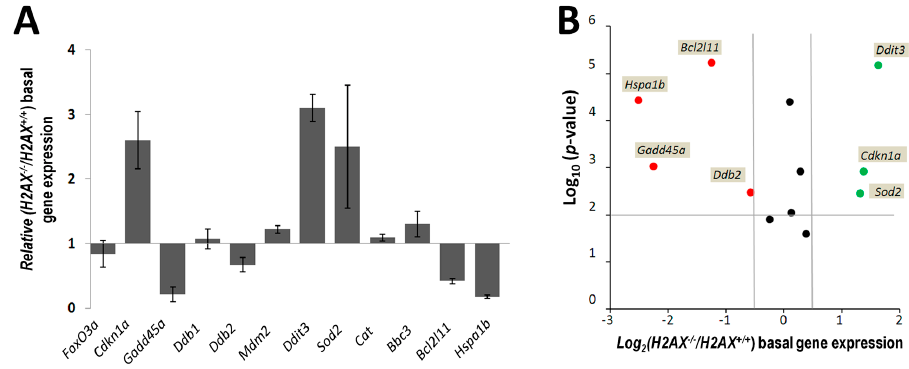
Figure 2. H2AX affects basal expression levels of genes regulated by FoxO3a. ( A ) Gene expression levels in H2AX − / − relative to H2AX + / + MEFs were measured in untreated exponentially growing cells using RT-qPCR as described in Experimental Section. Relative expression was calculated using 2 ´ ∆∆ Ct < 1 reflects decreased gene expression. Data represent the mean ˘ SD obtained from three independent experiments; ( B ) Volcano plot comparing altered basal gene expression in untreated H2AX ´{´ relative to H2AX +/+ MEFs. The X axis represents the log 2 ratio of the normalized gene signal (mean of the three experiments) of the H2AX ´{´ compared to H2AX +/+ cells. The Y -axis is expression regulation are set up to 1.5- and ´ 1.5-fold. Genes that are above the p = 0.01 threshold were considered statistically significantly altered and their names are shown next to the data points. Red, green and black dots signify down-regulated, up-regulated and not altered genes, respectively.